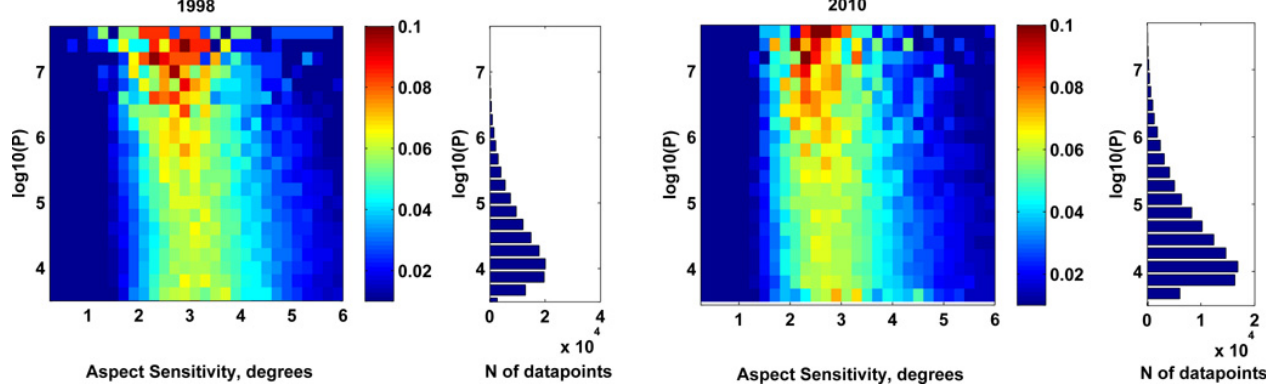
Fig. 6. The first and third panels: distribution of PMSE aspect sensitivity parameter for 1998 and 2010, respectively. Each row is normalized so that the sum of all data bins in it is 1. The second and fourth panels: number N of data points contributing to each row for 1998 and 2010, respectively.